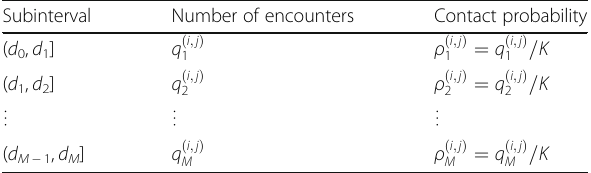
Table 1 Constrained relationship from algorithm 1 Subinterval Number of encounters Contact